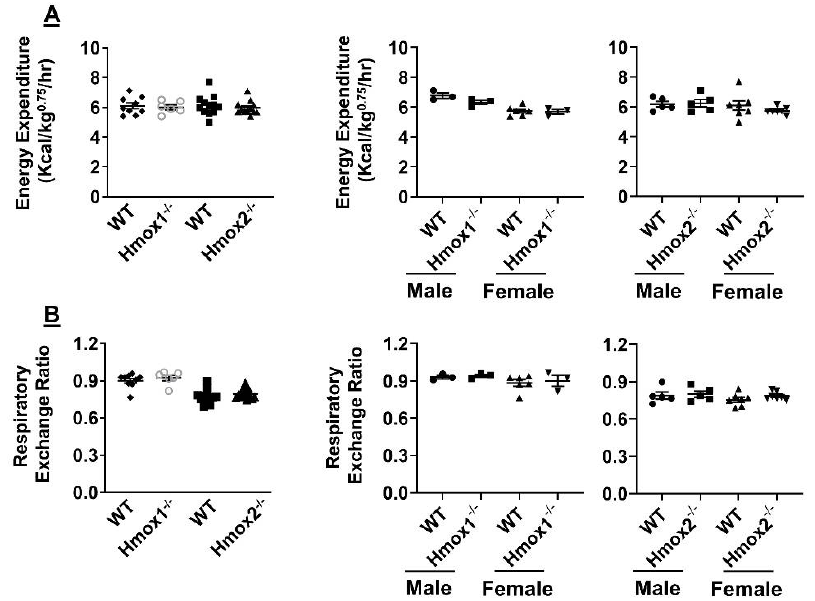
Figure 4. No changes in energy expenditure or respiratory exchange ratio in Hmox1 - / - and Hmox2 - / - mice. Energy expenditure and respiratory exchange ratio was measured using the metabolic chamber in Hmox1 - / - , Hmox2 - / - mice and their WT littermates (4–5 months old). Energy expenditure ( A ) and respiratory exchange ratio ( B ) were calculated. Data are expressed as mean ± SEM. n = 6–12.